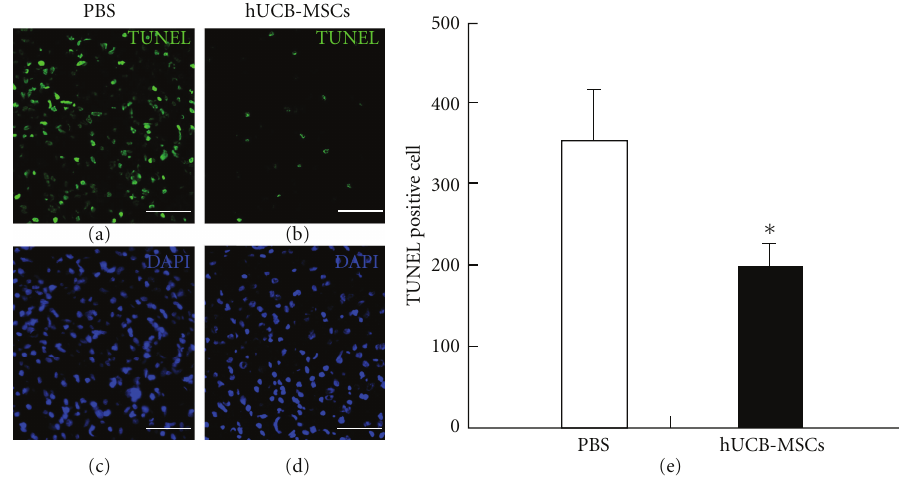
Figure 5: Protection of apoptosis by hUCB-MSCs as revealed by TUNEL assay in the injury site at 2 weeks after transplantation. (a)–(d) TUNEL staining (green) and staining with 4 (cid:3) ,6-diamidino-2-phenylindole (blue) indicate undergoing apoptotic cell death. (e) Quantity of TUNEL positive cells. The number of TUNEL positive cells was significantly reduced in cell transplantation group than in control group. ∗ P < 0 . 05, scale bars denote: 10 µ